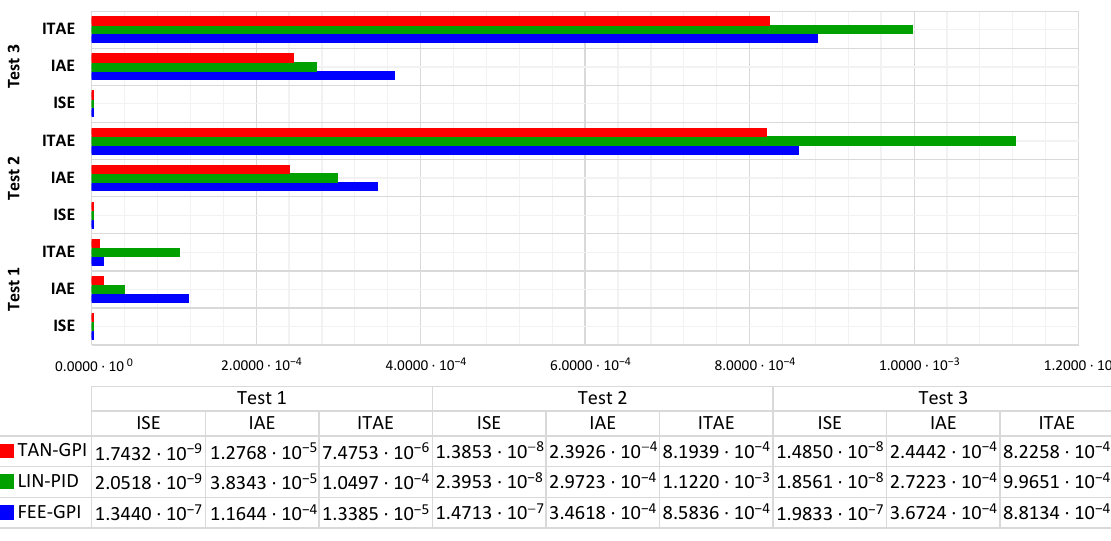
Figure 12. Performance of the control methods in different numerical